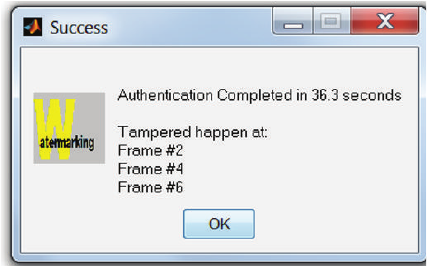
Figure 12: A message displayed after watermarking authentication process has been completed.